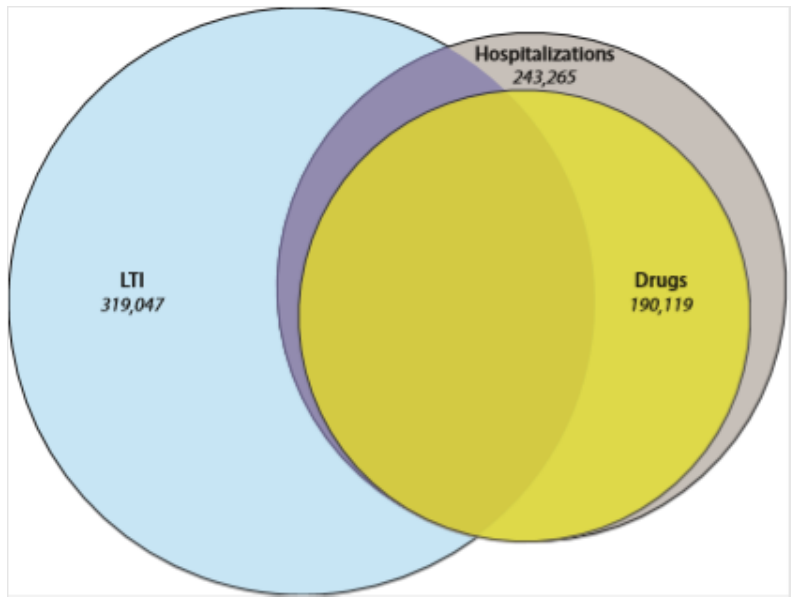
Figure 1. Mode of identification of patients treated for Severe Mental Illnesses (SMI). LTI: Long-Term Illness Scheme.